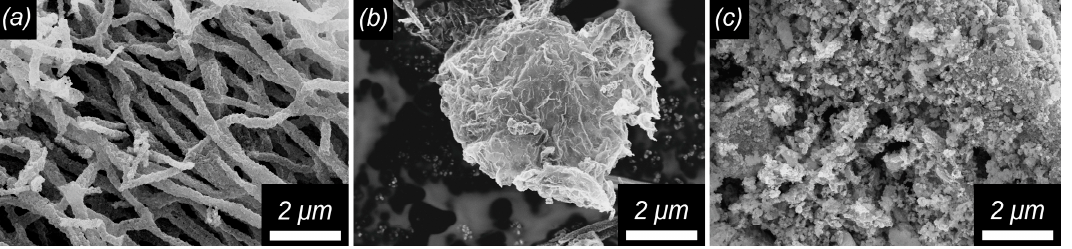
Figure 2. SEM images of ZnO nanofibers ( a ), rGO ( b ) and ZnO/rGO nanocomposite ( c ).